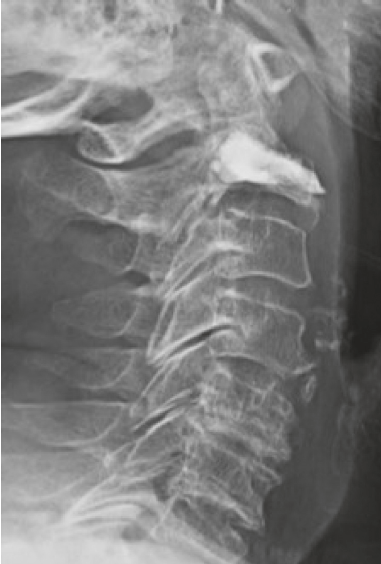
Figure 1: Lateral extended view showing bone filter and meth- ylmethacrylate filled into C2 curettage.